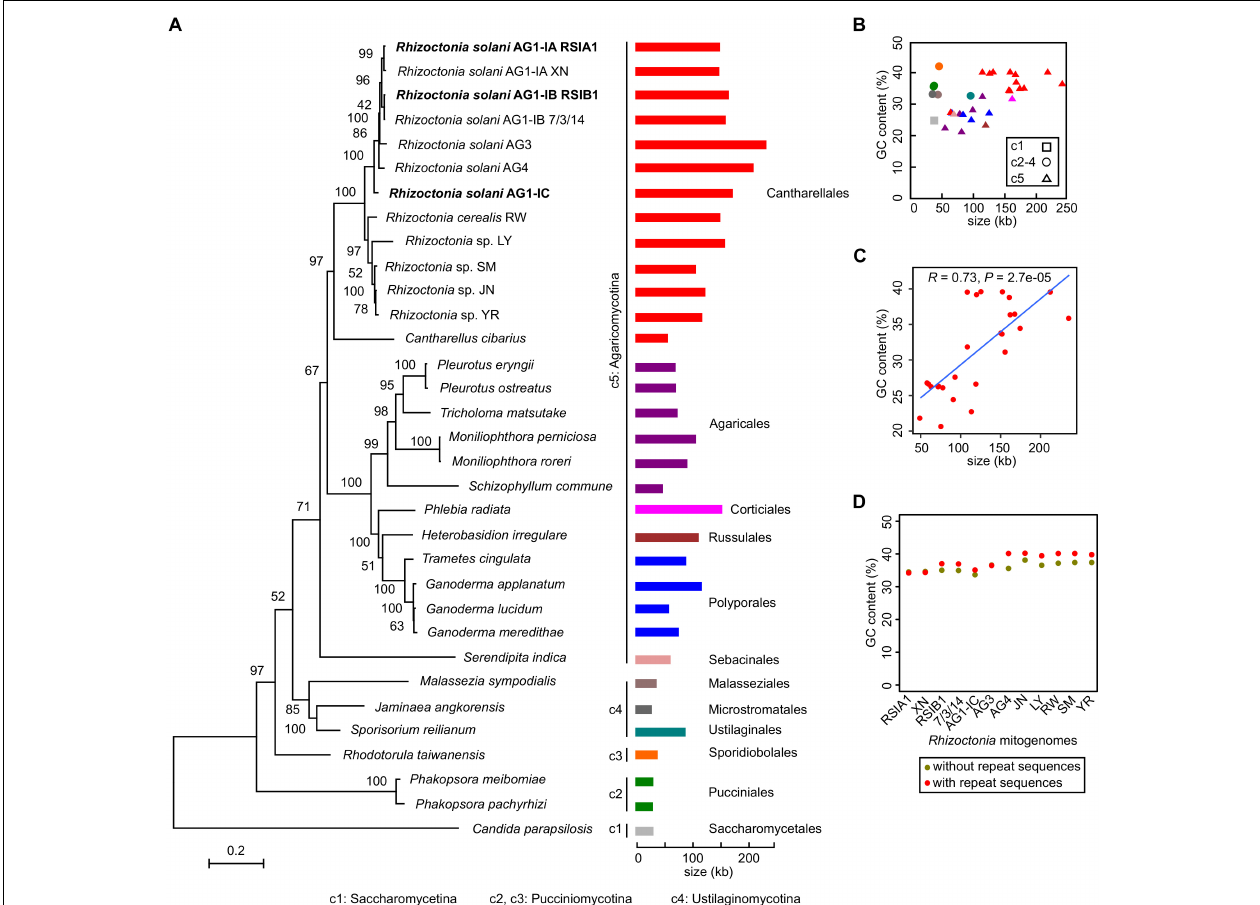
FIGURE 2 | Phylogenetic relationships between Rhizoctonia solani and other fungi in Basidiomycota. (A) The mitogenome phylogeny of 33 fungal strains. The Candida parapsilosis in Ascomycete was used as the outgroup. The maximum-likelihood bootstrap values were shown. The sizes of mitogenomes were shown with different colors for strains from different orders. The newly reported complete mitogenomes were marked in bold. (B) Distribution between sizes and GC content from 33 fungal mitogenomes. (C) Positive relationship between GC content and mitogenomic sizes for Agaricomycotina mitogenomes. (D) Distribution of GC content in Rhizoctonia mitogenomes with and without repeat